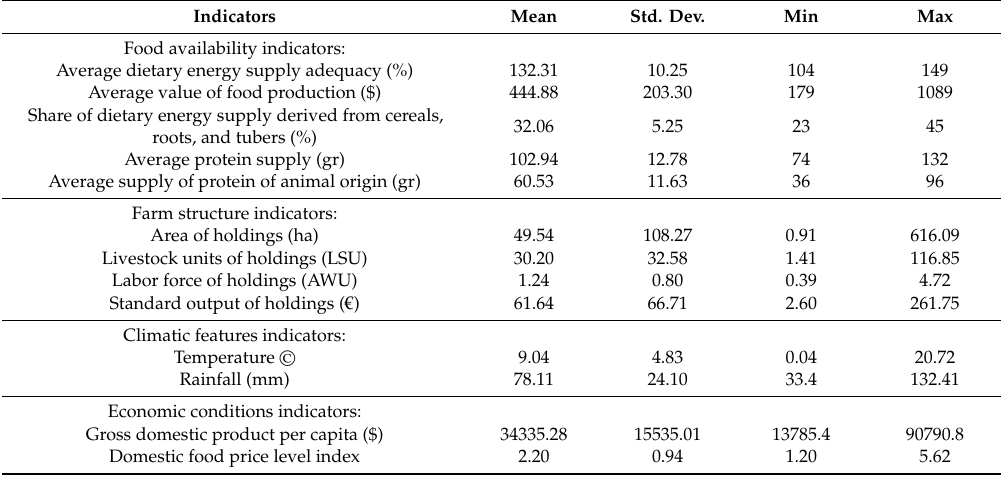
Table 2. Descriptive statistics of the data used in the study (EU + EFTA, 2010); Source: [7,34,35] and own calculations; n =